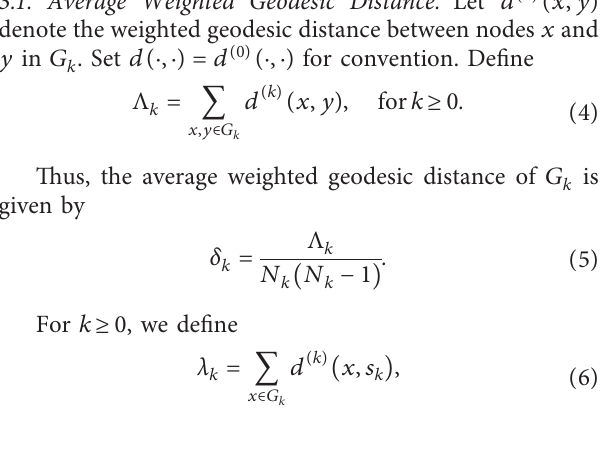
Figure 4: In G 0 , black lines denote edges of weight 1, blue lines denote edges of weight 0.375, and orange lines denote edges of weight 0.25. (a) S 1 . (b) S 2 . (c) G 0 .